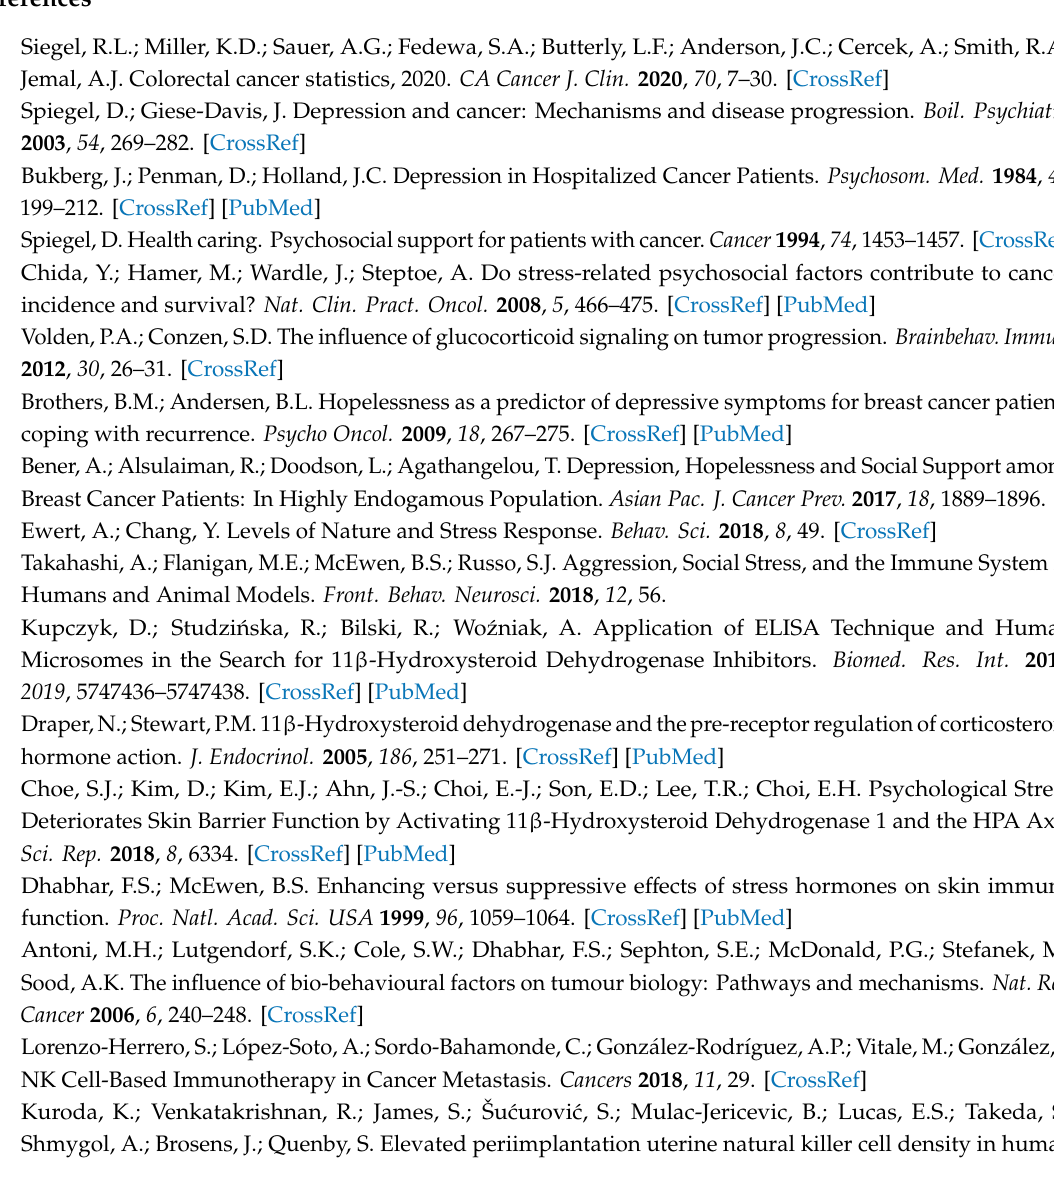
NMR spectra of compounds 3a , Figure S2.2: 13 C NMR spectra of compounds 3b , Figure S2.3: 13 C NMR spectra of compounds 3c , Figure S2.4: 13 C NMR spectra of compounds 3d , Figure S2.5: 13 C NMR spectra of compounds 3e , Figure S2.6: 13 C NMR spectra of compounds 3f , Figure S2.7: 13 C NMR spectra of compounds 3g , Figure S2.8: 13 C NMR spectra of compounds 3h , Figure S2.9: 13 C NMR spectra of compounds 3i , Figure S3.1: HRMS spectra of compounds 3a , Figure S3.2: HRMS spectra of compounds 3b , Figure S3.3: HRMS spectra of compounds 3c , Figure S3.4: HRMS spectra of compounds 3d , Figure S3.5: HRMS spectra of compounds 3e , Figure S3.6: HRMS spectra of compounds 3f , Figure S3.7: HRMS spectra of compounds 3g , Figure S3.8: HRMS spectra of compounds 3h , Figure S3.9: HRMS spectra of compounds 3i